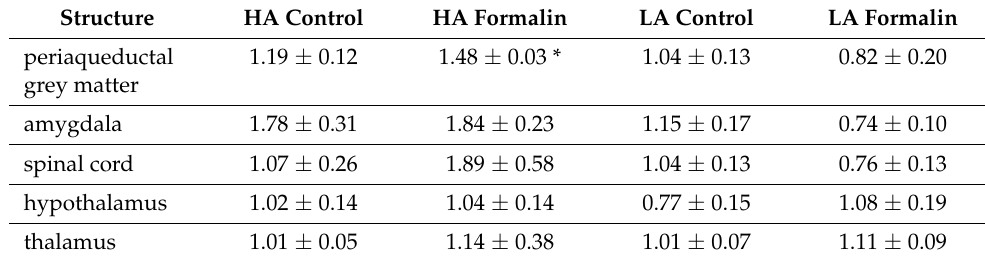
Table 5. Kappa opioid receptor 1 (Oprk1) mRNA levels in HA and LA mice in the interphase of the formalin test. Mice were injected with 5% formalin (in PBS) into the dorsal aspect of the hind paw ( n = 4–6). Samples were harvested 15 min post-formalin. Results were analysed within each line with two-way ANOVA followed by Bonferroni’s post-hoc test. Statistical significance was depicted as follows: * p ≤ 0.05 (vs.